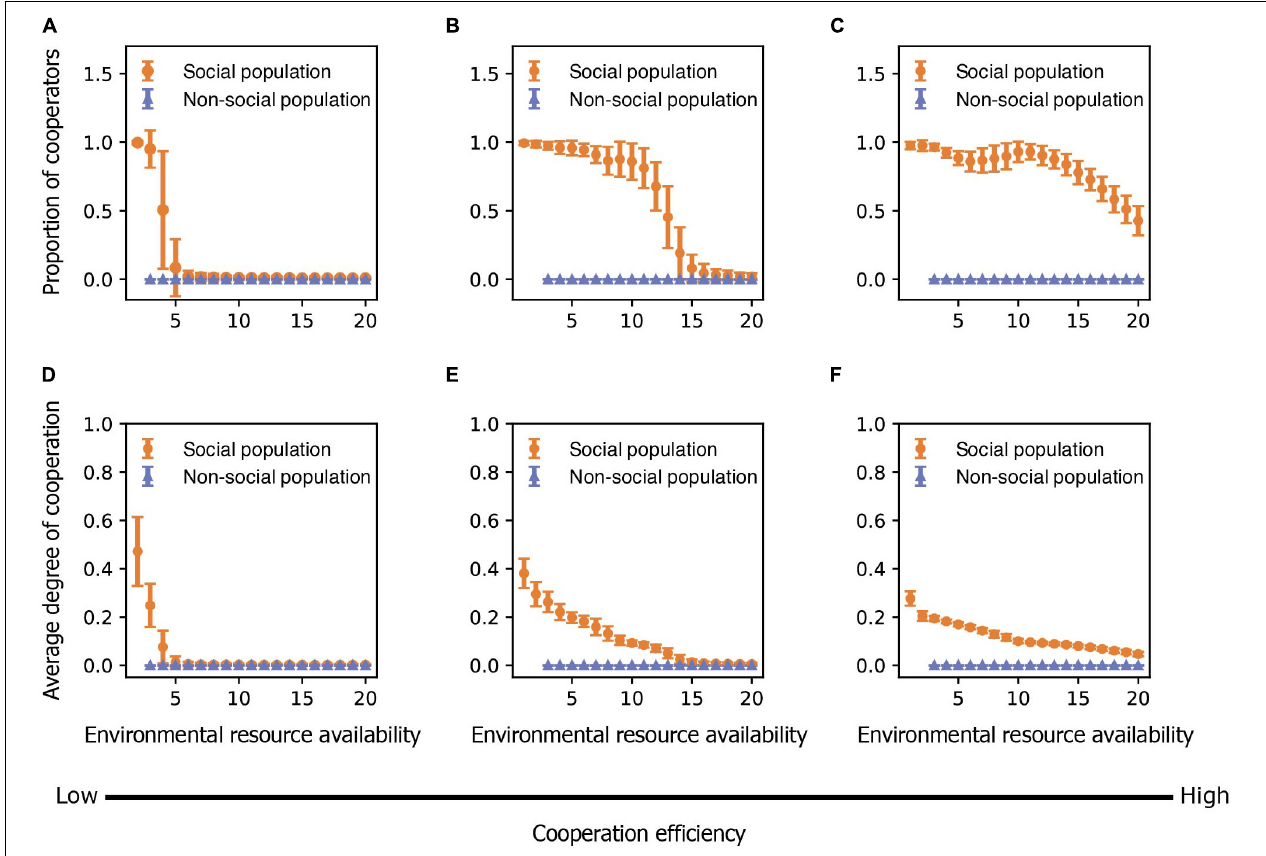
FIGURE 3 | The evolution of cooperation and sociality is influenced by both variation in environmental resource availability and cooperation efficiency. (A–C) The mean proportion of cooperators in populations in relation to environmental resource availability as cooperation efficiency is (A) low ( b K = 1), (B) medium ( b K = 3), and (C) high ( b K = 5). (D–F) The mean degree of cooperation that individuals exhibit in relation to environmental resource availability as cooperation efficiency is (D) low ( b K = 1), (E) medium ( b K = 3), and (F) high ( b K = 5). Points represent means and bars represent standard deviations. Each mean and standard deviation is calculated on the output data of 500 simulations. The proportion of cooperators and degree of cooperation of non-cooperators are